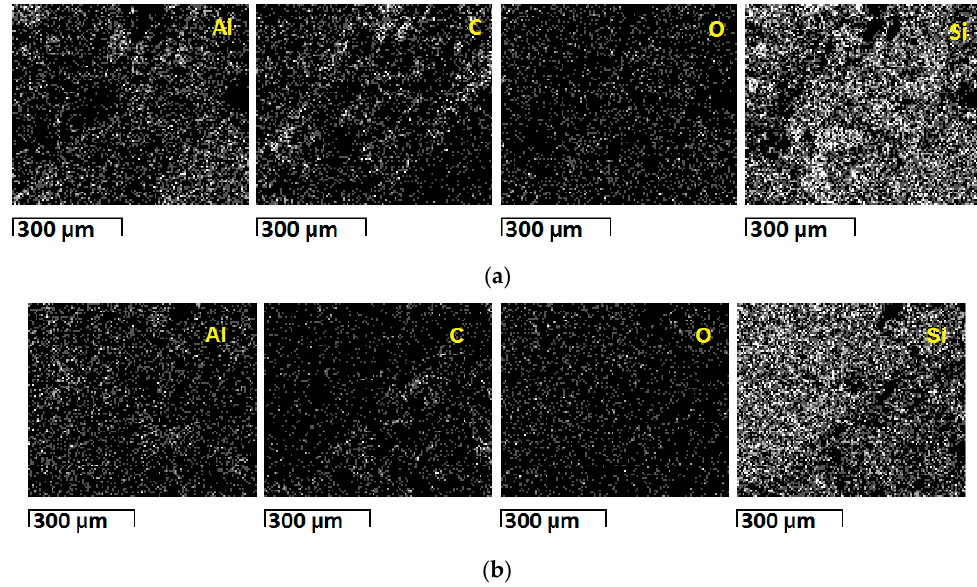
Figure 11. Micro EDS through mapping of the main elements established in SEM assays for the samples ( a ) V-OC-M; ( b ) V-AiO-M.